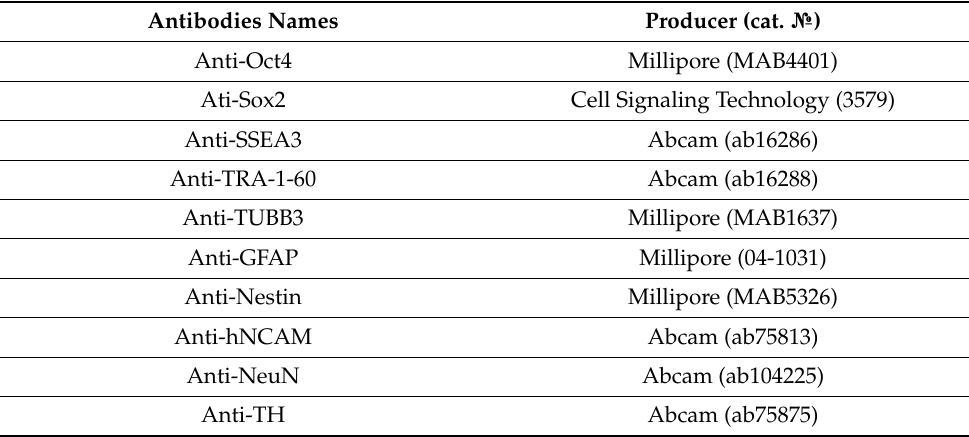
Table 1. Primary antibodies for immunofluorescent staining.